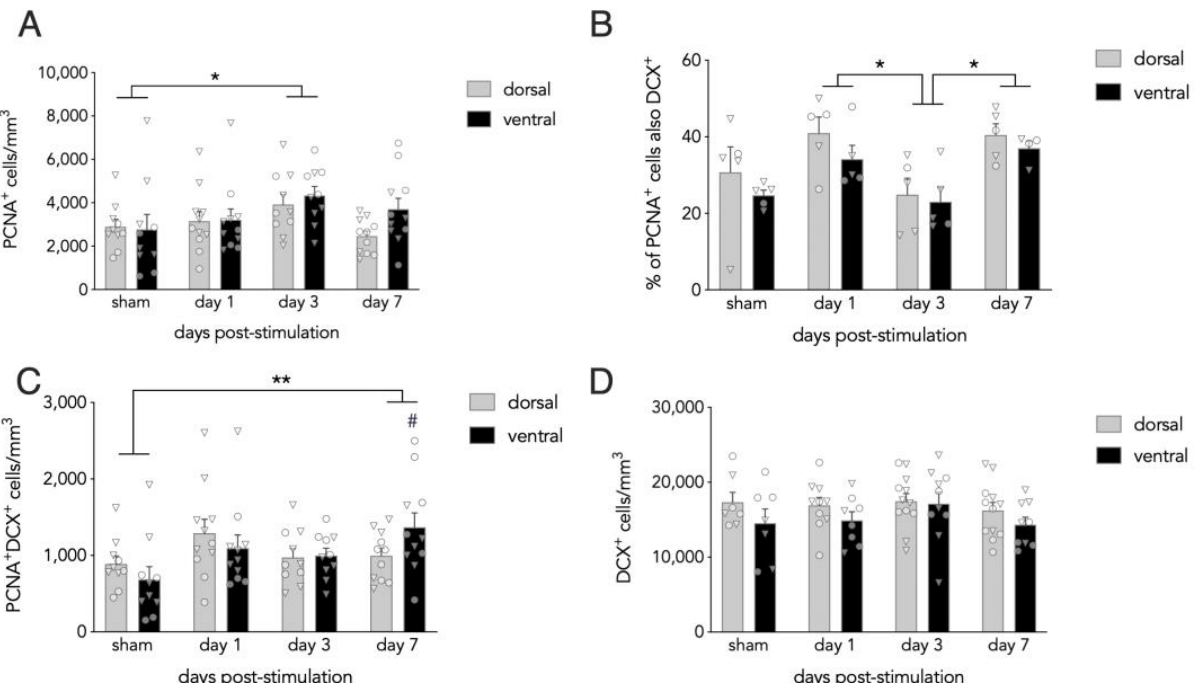
Figure 2. Time course of neurogenesis following one session of ECS. ( A ) The density of proliferating PCNA + cells increased on day 3 post-ECS compared to sham animals and was similar in the dorsal and ventral dentate gyrus. ( B ) The proportion of PCNA + cells that expressed DCX was lower on day 3 than on days 1 and 7. ( C ) The total number of PCNA + DCX + cells was elevated on day 7 relative to the sham group and elevated in the ventral DG relative to all other groups. ( D ) ECS did not alter DCX + cell density. Bars reflect mean ± standard error. Triangles indicate female mice; circles indicate male mice. * p < 0.05, ** p < 0.01, # p ≤ 0.001/0.03/0.02 vs sham/day 1/day 3.